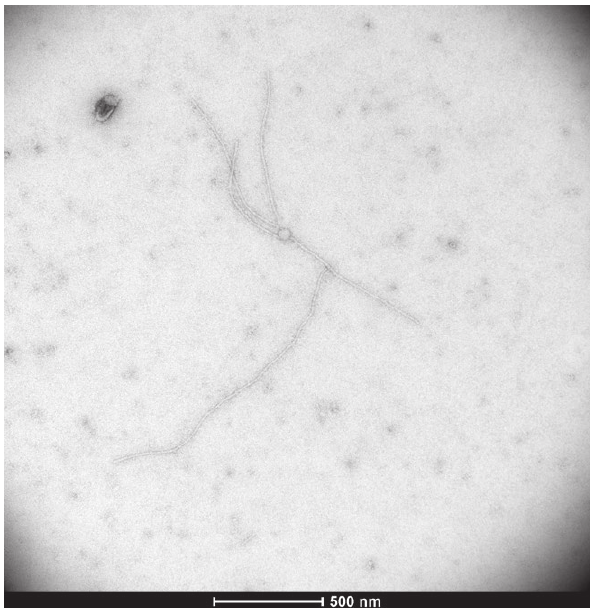
Figure 2. Transmission electron microscopy showing particles of Garlic virus D from garlic plants (negative staining with 1 % uranyl acetate). Particle sizes are approx. 800 nm length and 12 nm diam- eter. Bars represent 500